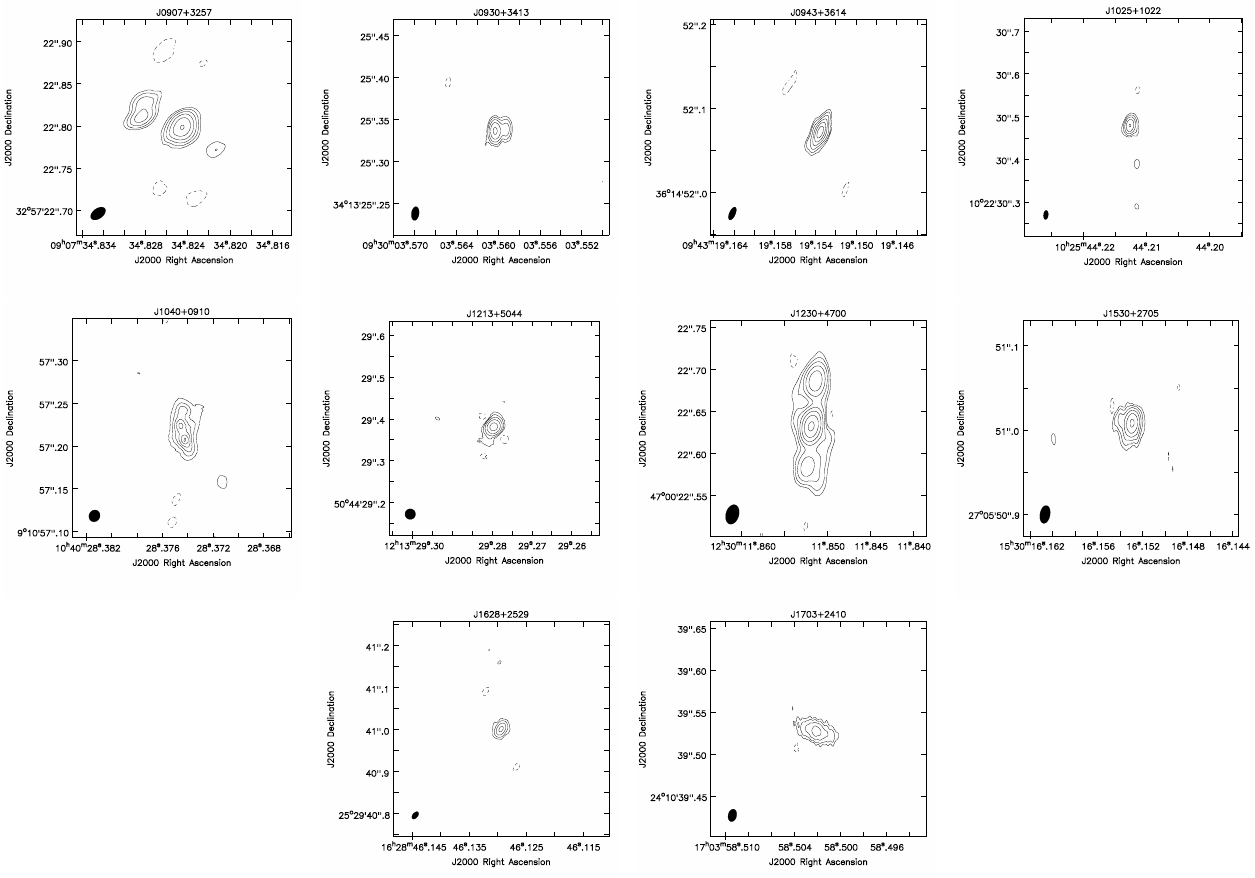
Figure 3. The 1.66 GHz EVN observations of 10 FR 0s. The filled area, shown at the bottom-left corner of the images, represents the restoring beam of the maps. Contours and beam parameters are given in Table